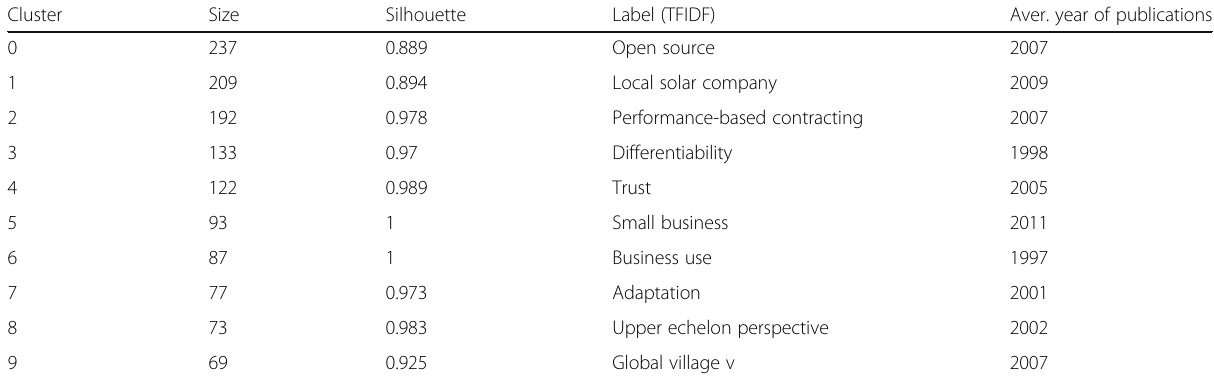
Table 3 TOP 10 clusters of extended dataset Cluster